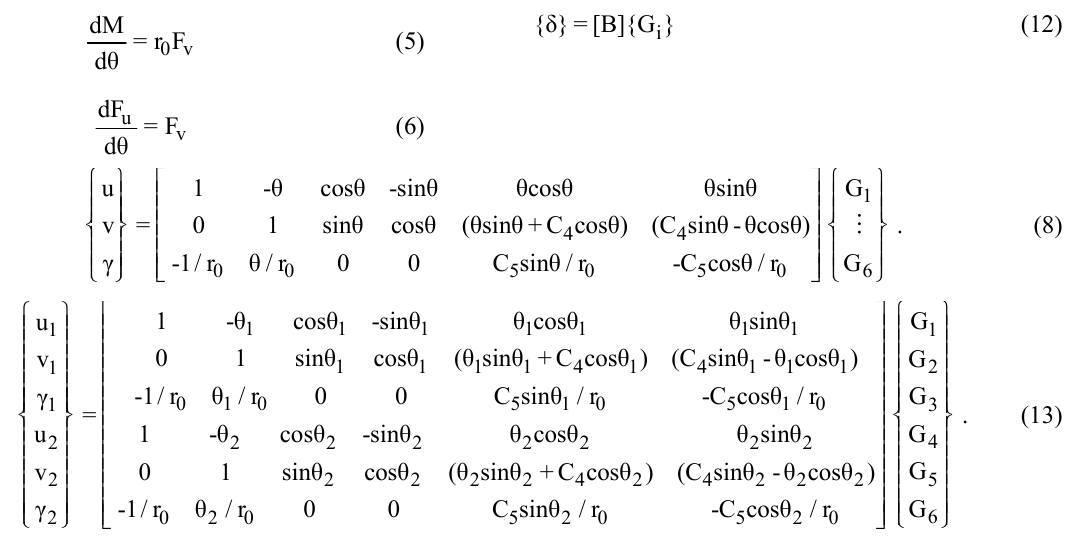
The three static equilibrium relations for this element are written as (5) to